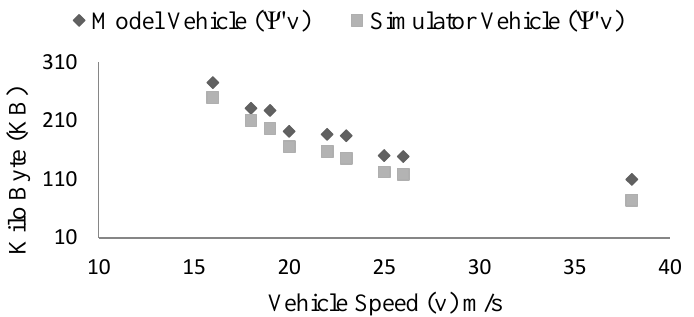
Figure 14. Comparison of the simulation and model measurements of vehicle storage requirements in case of varying vehicle speed ( v